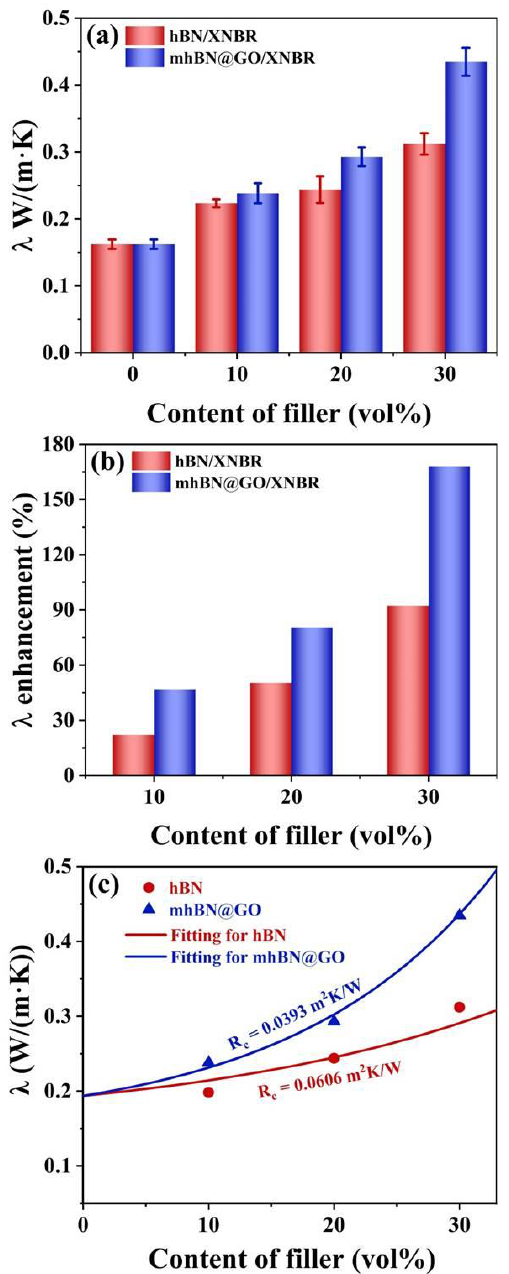
Figure 8. ( a ) The λ of hBN/XNBR and mhBN@GO/XNBR composites with different filler loading. ( b ) The enhancement in λ of hBN/XNBR and mhBN@GO/XNBR composites relative to that of the neat XNBR. ( c ) Fitting λ of hBN/XNBR and mhBN@GO/XNBR composites using the modified Hashin-Shtrikman model.